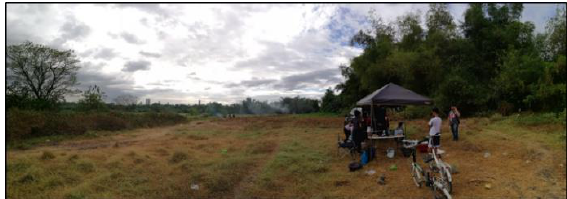
Figure 2. The project site: Open